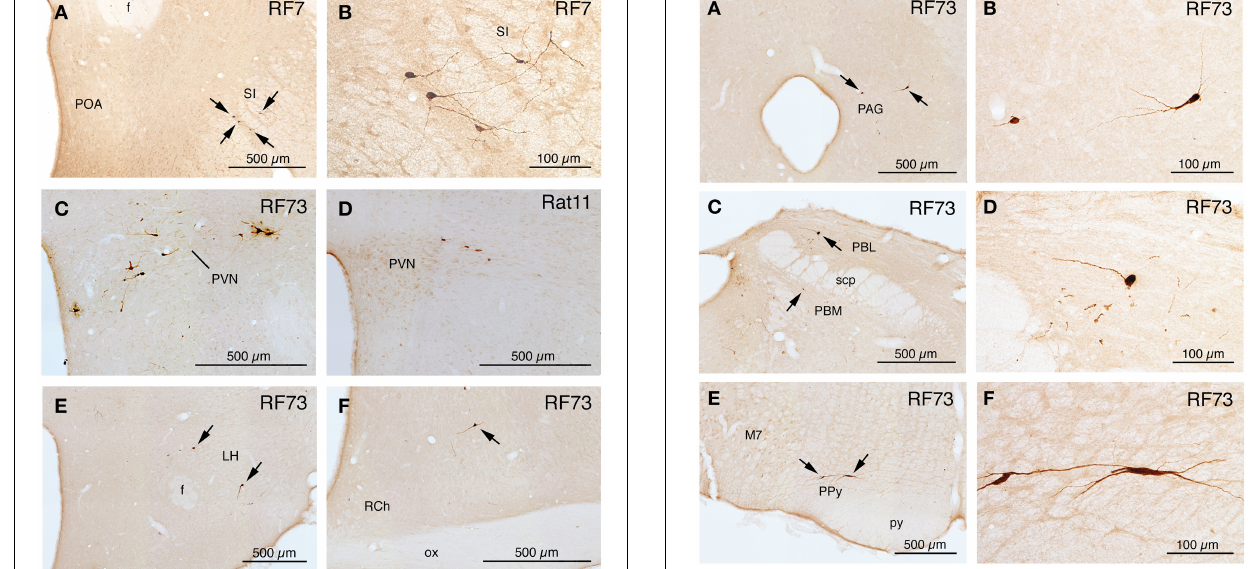
FIGURE 4 | Images of PRV-labeled neurons in the diencephalon and telencephalon after an intrachoroidal injection of virus into the right eye, with the labeled neurons detected by PAP immunolabeling with DAB. (A,B) Show low and high power views of PRV + neurons (arrows) in the substantia innominata (SI) of RF7, near the preoptic area (POA). (C,D) Show PRV + neurons in the right paraventricular nucleus (PVN), from RF73 and R11, respectively. (E,F) Show PRV + neurons (arrows) in the lateral hypothalamus (LH) and retrochiasmatic area of the hypothalamus (RCh), from RF73. All images are of coronal sections. Abbreviation: ox, optic chiasm.